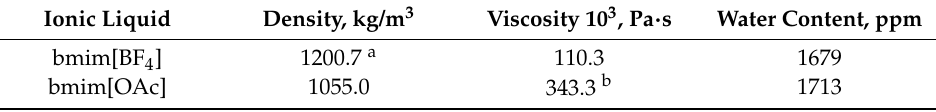
Table 1. The physical properties and water content of bmim[BF 4 ] and bmim[OAc]. Ionic